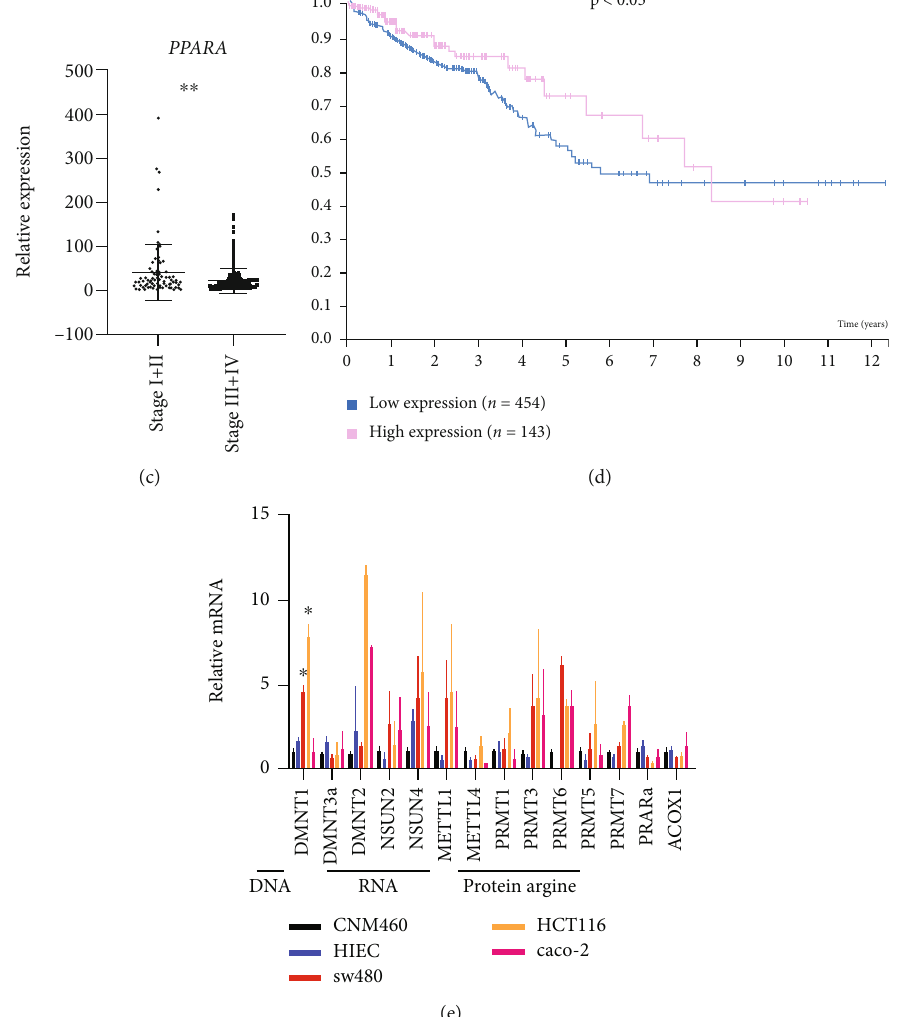
Figure 1: Bioinformatics analysis of PPARA in pancancer: (a) the box plot showing the expression levels of PPARs, DNMT1, PRMT6, ACOX1, and CDKN2A in tumorous tissues; (b) the forest graph showing the hazard ratio of PPARs, ACOX1, CDKN2A, methylation transferase DNMT1, DNMT3a, and PRMT6 in various cancers; (c) box plots of PPARA expression detected in RNA-seq in colon cancer specimens grouped into stage I + II and stage III + IV ; (d) survival curve of patients with di ff erent PPARA protein expression levels in colon cancer ( P < 0 : 05 ); (e) the relative mRNA expression of PPARA, ACOX1, and methylation transferases was measured using qRT- PCR in SW480, HCT116, Caco-2, HIEC, and NCM460 cell lines. The data is expressed as mean ± SD ( ∗ P < 0 : 05 , ∗∗ P < 0 : 01 , ∗∗∗ P < 0 : 001